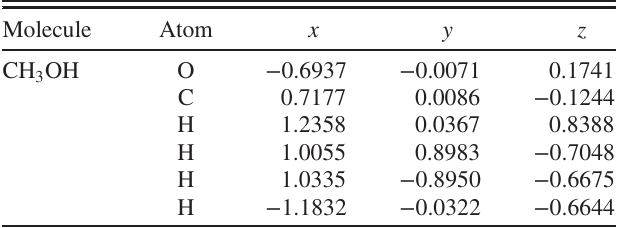
TABLE V. Optimized geometry of CH 3 OH given in Cartesian